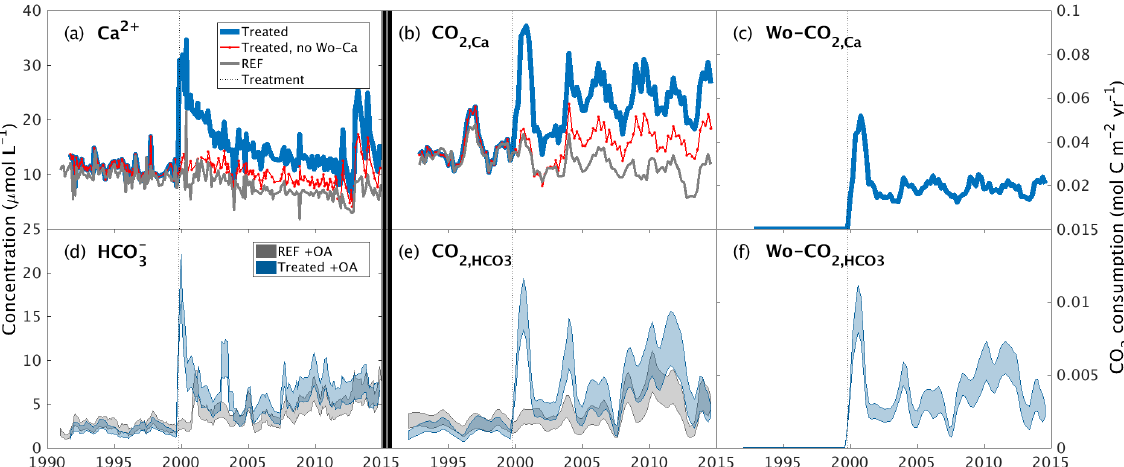
Figure 2. Inorganic CO 2 capture at the Hubbard Brook Experimental Forest. (a) Observed calcium and (b) calcium export in the reference (grey) and treated (blue) watersheds along with the contribution from sources other than wollastonite (red) and the time of treatment (vertical dotted line). (c) Calculated CO 2 consumption due to the treatment (Wo-CO 2 , Ca , Eq. 9). (d) Modelled stream-water bicarbonate, (e) CO 2 consumption (CO 2 , HCO , Eq. 5), and (f) CO 2 consumption due to the treatment (Wo-CO 2 , HCO , Eq. 7); colours as for calcium. Simula- 3 3 tions (d–f) account for the presence of organic acids ( + OA). All calcium export (b) and CO 2 consumption curves (c, e, f) were calculated with flow-normalized concentrations and corrected for sparsity of samples